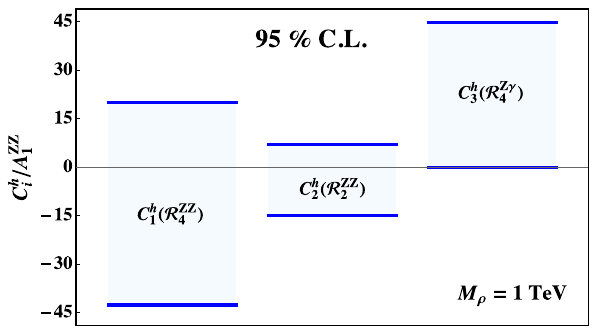
/ A ZZ using Eq. (18) and taking as input the CMS i 1